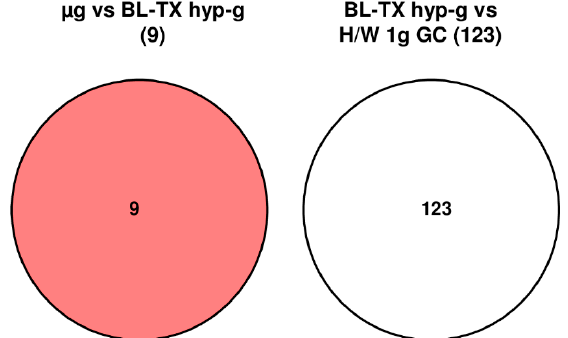
Figure 5. Strategy for the identification of hypergravity- and microgravity-sensitive probe sets from human Jurkat T cells during the TEXUS-51 sounding rocket flight. The different comparisons for hypergravity and microgravity-sensitive probe sets are displayed as Venn-diagrams. In the circles numbers of probe sets are given that are differentially expressed with a p -value < 0.05. The red area shows the number of microgravity-sensitive probe sets. There is no overlap between the identified probe sets for the comparisons µg versus BL-TX hyp-g and BL-TX hyp-g versus H/W 1 g GC. For the abbreviations of the experiment group names see Table 1. Table 4. Numbers of differentially expressed probe sets in response to altered gravity conditions in Jurkat T cells during TEXUS-51 sounding rocket flight. Direct comparisons between the sample groups are shown.